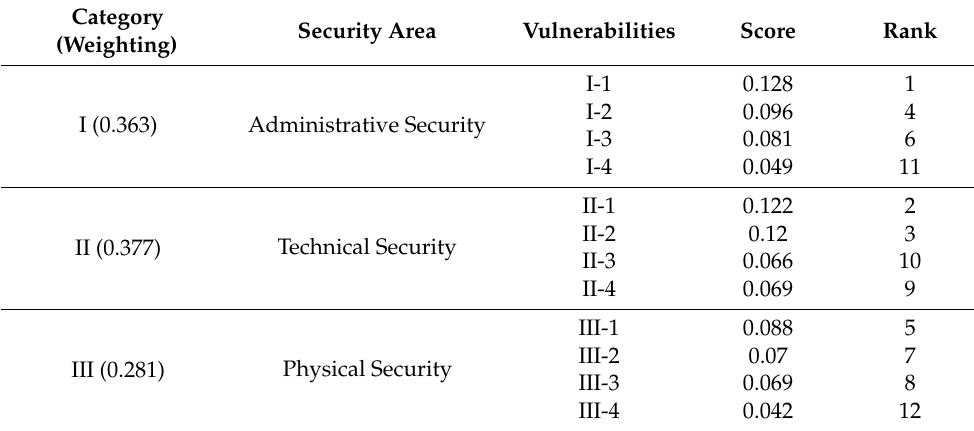
Table 5. AHP analysis results for prioritizing cybersecurity vulnerability